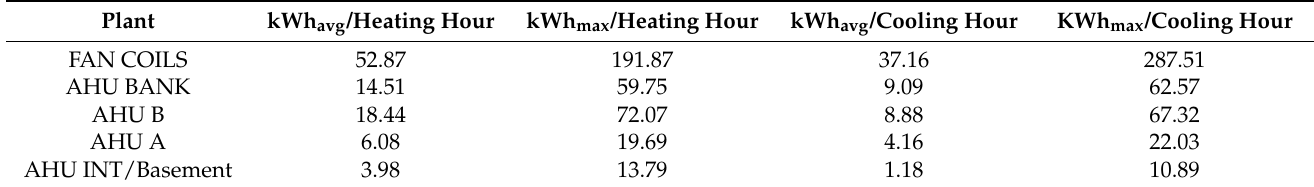
Table 7. Supply hourly thermal/cooling energy values.